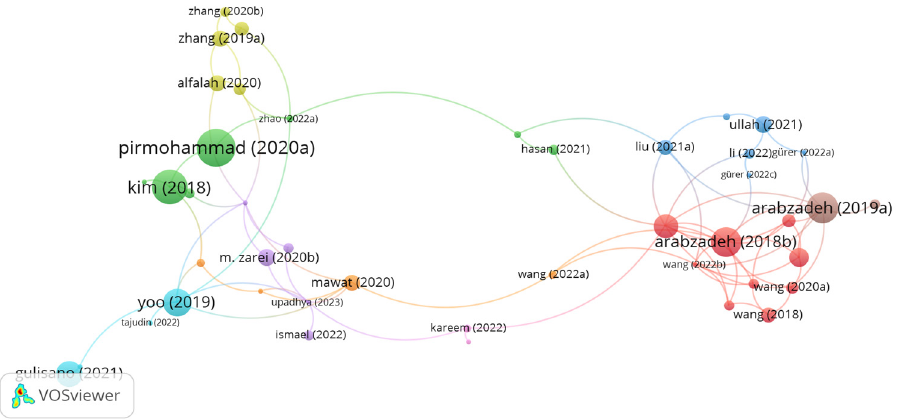
Figure 7. Network visualization of carbon